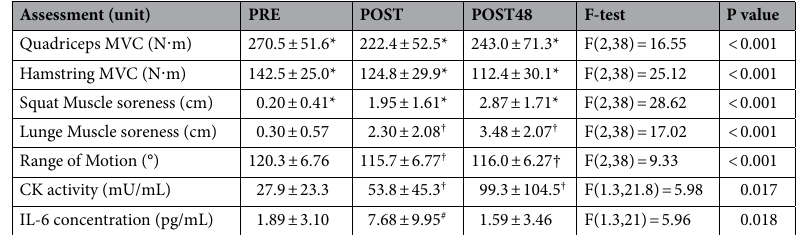
Table 2. Effect of the repeated maximal sprint intervention on muscle damage-biomarkers. Values are mean ± SD. One-way ANOVA, F- and P-values are reported. MVC maximal voluntary contraction, CK creatine kinase, IL-6 interleukin-6. *Significant differences between all time points. † Differences PRE-to-POST and PRE-to-POST48 (P < 0.05). # Differences PRE-to-POST and POST-to-POST48 (P < 0.05).